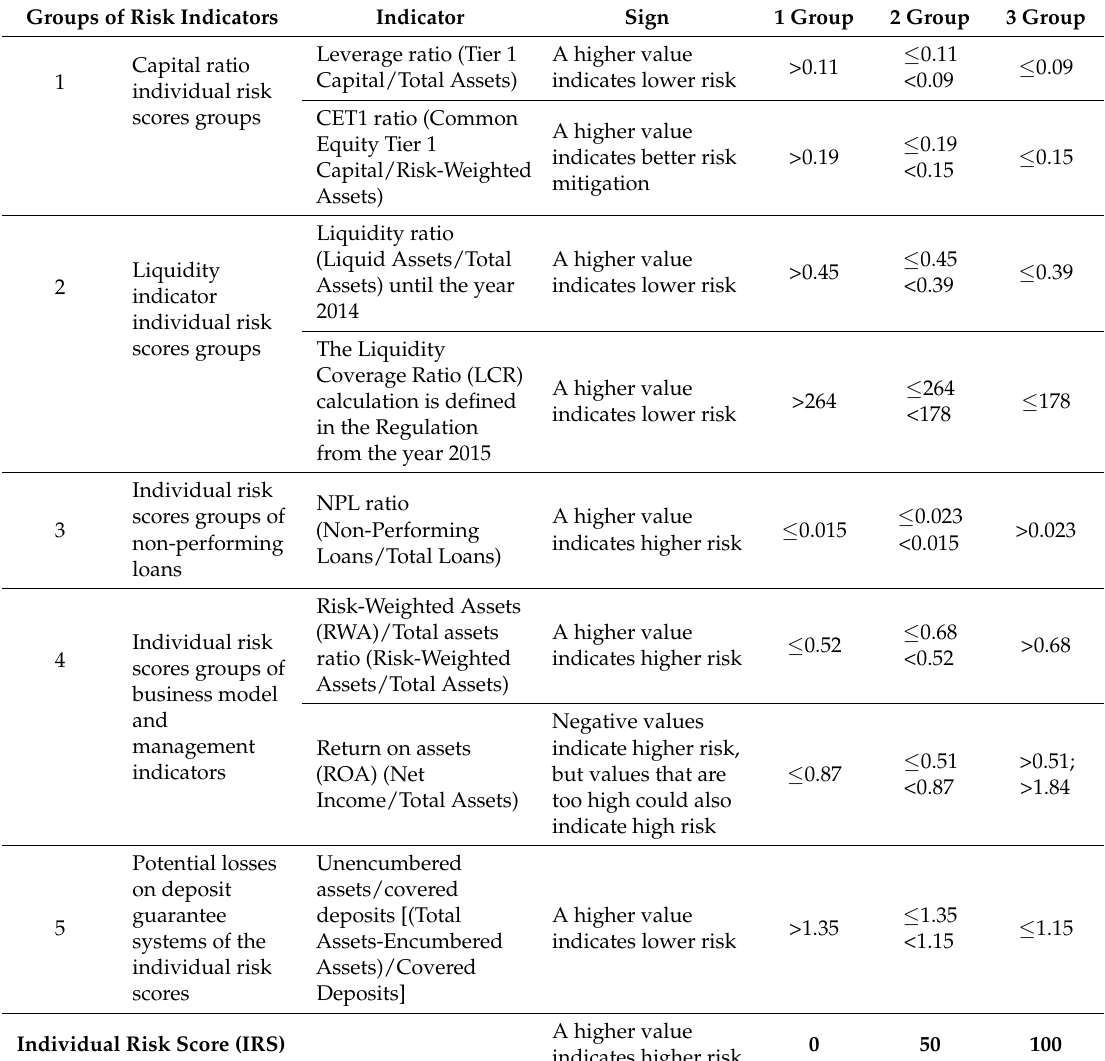
Table 1. The European Banking Authority’s risk indicators and groups of individual risk scores.